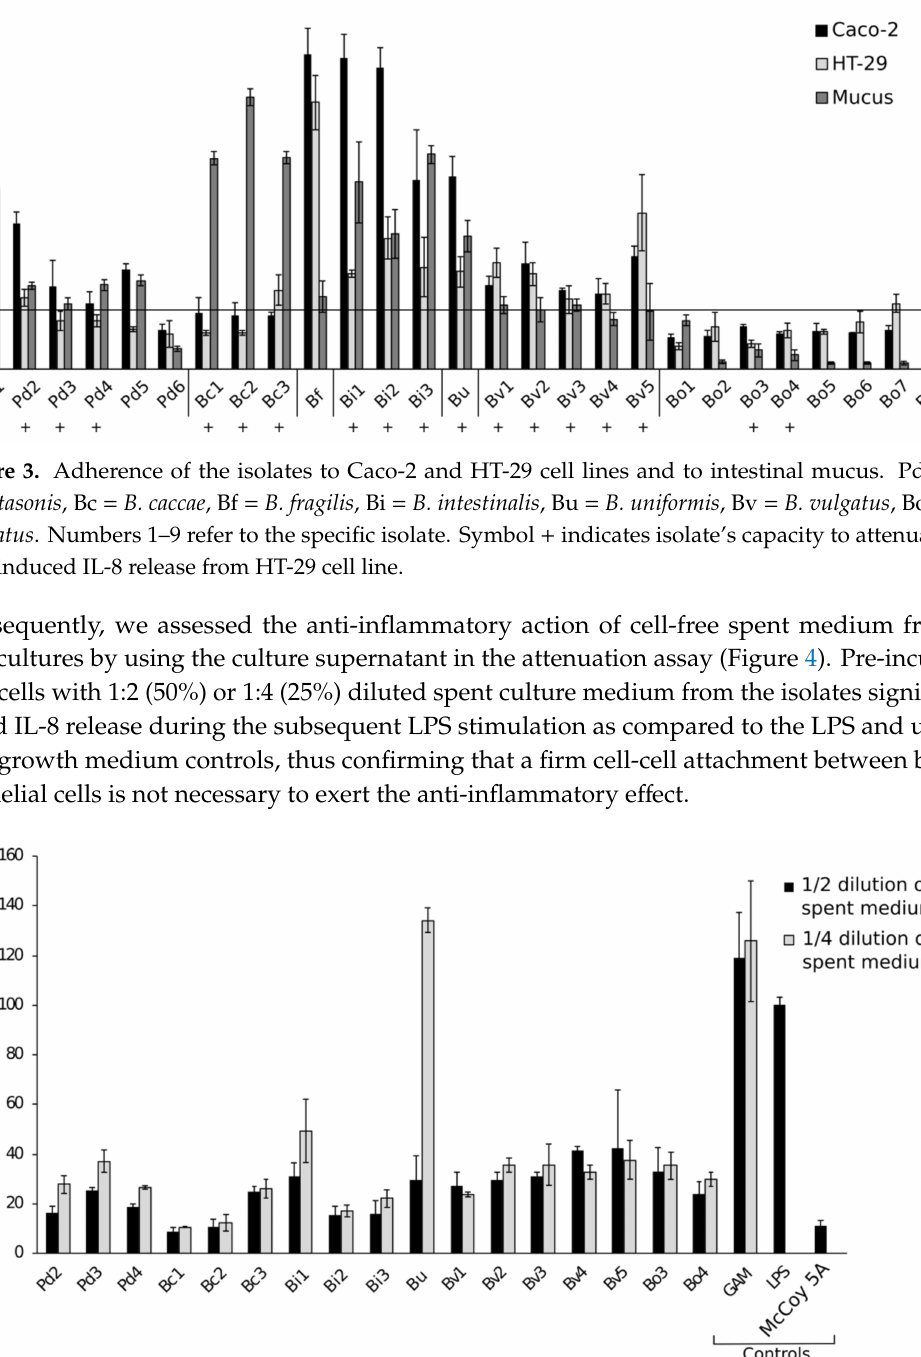
and 1 dilutions of spent media were used in 2 4